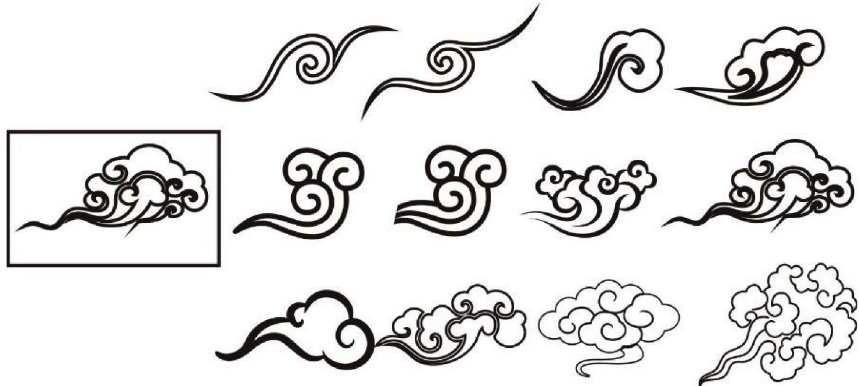
Figure 12: The production results of cloud body under different parameters.